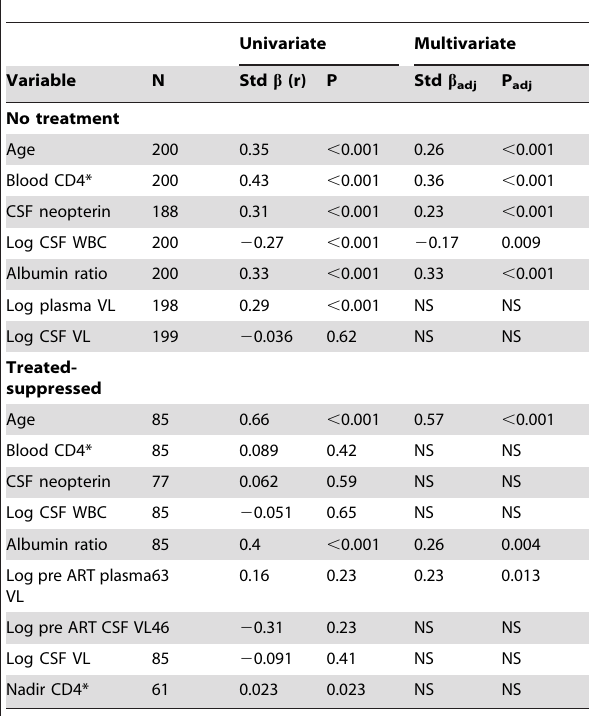
Table 2. Univariate correlation (left columns) and multiple linear regression (right columns) determining predictors of log 10 CSF NFL in HIV-infected neuroasymptomatic patients with and without antiretroviral treatment.